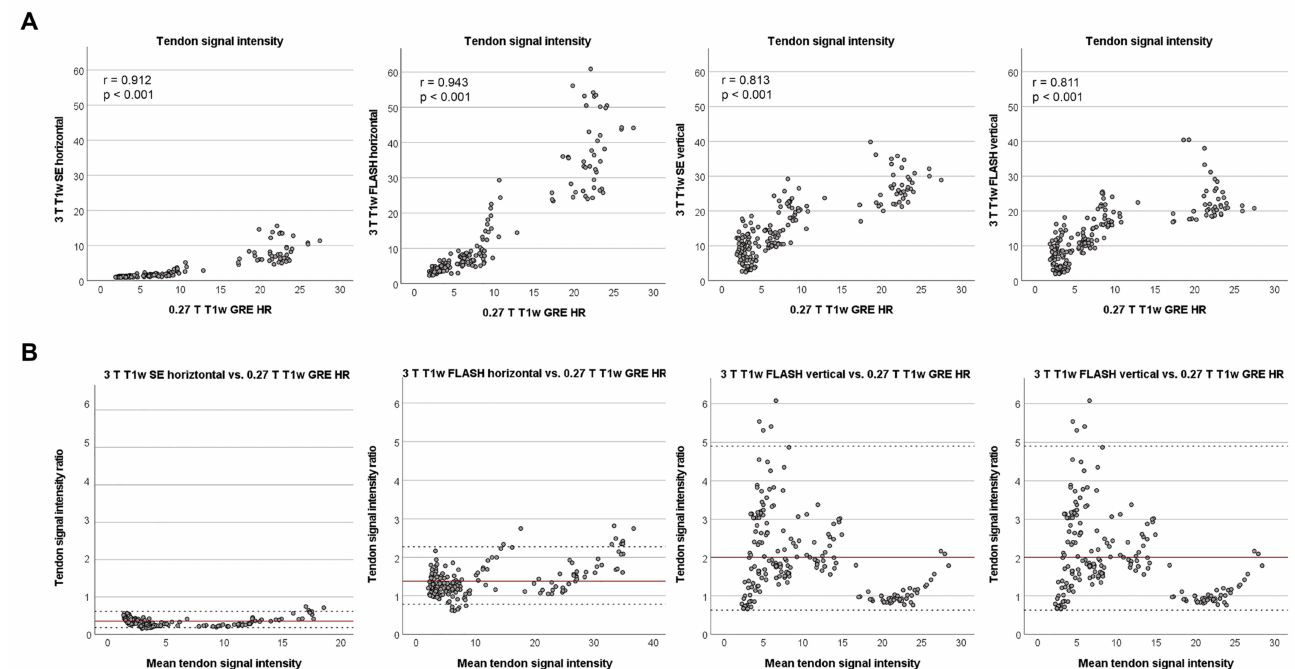
Figure 3. Relationship between tendon signal intensities in T1w high- and low-field MRI. ( A ) The dot plots display the tendon signal intensity in all T1w high-field (3 T) sequences versus tendon signal intensity in the low-field (0.27 T) T1w GRE sequence. All correlations were strong and highly significant. ( B ) The Bland–Altman plots demonstrate that only the high-field SE sequence in horizontal orientation had consistently lower signal intensities than the low-field T1w GRE sequence. The other T1w high-field sequences displayed on average higher signal intensities than the low-field T1w GRE sequence. Data were obtained from n = 195 matched